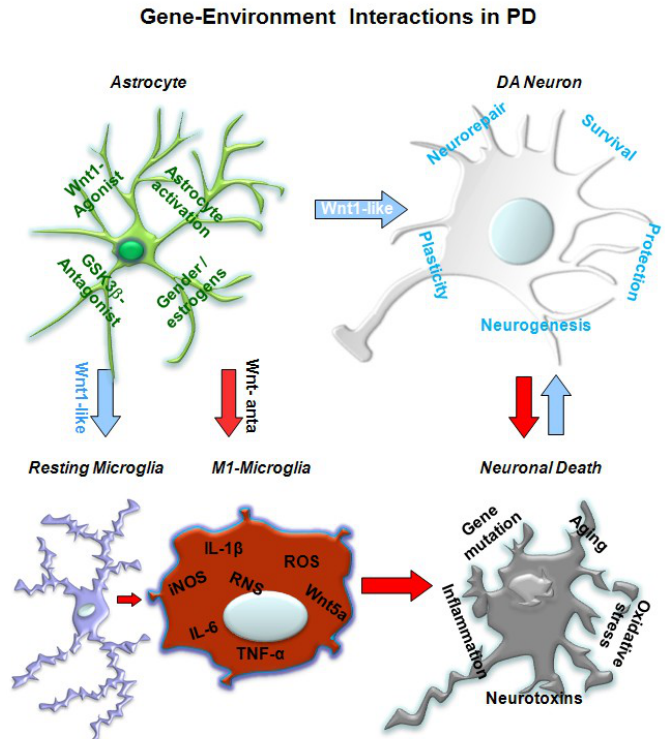
Figure 3. Schematic illustration of Wnt1/ β -catenin signaling as a key player in glia–neuron cross-talk. A simplified scheme linking reactive astrocytes, mcroglia, and Wnt/ β -catenin signaling to mDAergic neuron survival/death is summarized according to our published findings [49–57]. Upon injury, a number of conditons, including astrocyte activation, the genetic and hormonal background (i.e., gender and estrogens), and endogenous and exogenous activators of Wnt/ β -catenin signaling components (i.e., GSK-3 β -antagonists), can promote astrocyte beneficial effects via the expression of a panel of growth/neurotrophic factors, particularly Wnt1, contributing to the survival, repair, and neurorescue of DA neurons, via direct neuronal effects (see Figure 2) and through the inhibition of the microglia-M1 activated phenotype. Astrocytes of the ventral midbrain, via activation of Wnt/ β -catenin signaling, can also promote neurogenesis and DAergic neurogenesis from adult neural stem/progenitor cells. By contrast, aging, MPTP exposure, and genetic mutations exacerbate microglia activation, with upregulation of a wide panel of pro-inflammatory mediators including tumor necrosis factor α (TNF- α ), interleukin 1 β (IL-1 β ), Wnt5a, inducible nitric oxide synthase (iNOS-derived) nitric oxide (NO) and reactive oxygen (ROS) and reactive nitrogen (RNS) species. Neurotoxic injury or increased oxidative load as a result of gene–environment interactions may antagonize Wnt/ β -catenin signaling in DA neurons by upregulating active GSK-3 β , leading to β -catenin degradation and increased DA neuron